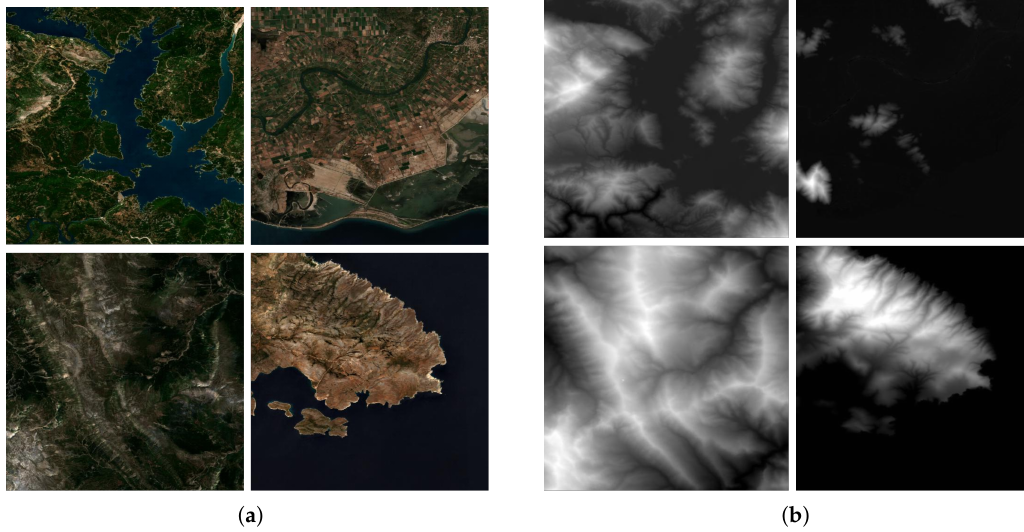
Figure 4. Example ( a ) satellite images and ( b ) DEM tiles over different locations of Greece. The diversity of the landscape is apparent, highlighting the difficulty of the